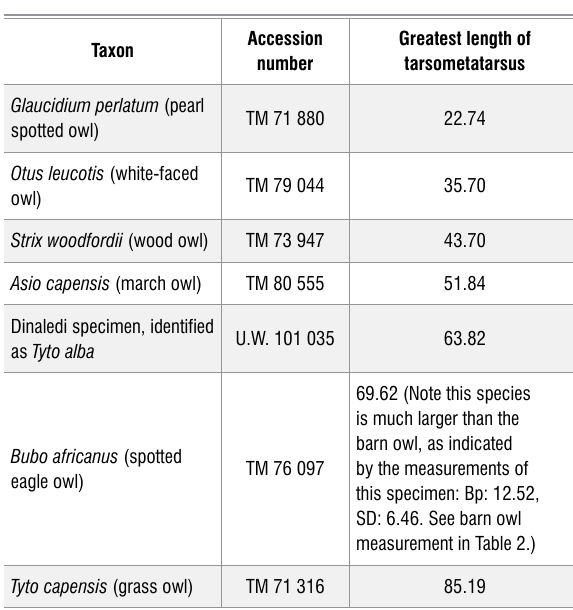
Scale bar equals 1 cm ch, crista medialis hypotarsi; fsm, facies subcutanea medialis; fvd, foramen vasculare distale; T, trochlea figure 2: Specimen U.W. 101 035, a left tarsometatarsus, is almost complete, with only the 3rd and 4th trochleas partially absent. The specimen is from an adult individual. (a) Dorsal, (b) lateral, (c) plantar and (d) medial views. Greatest length of tarsometatarsus